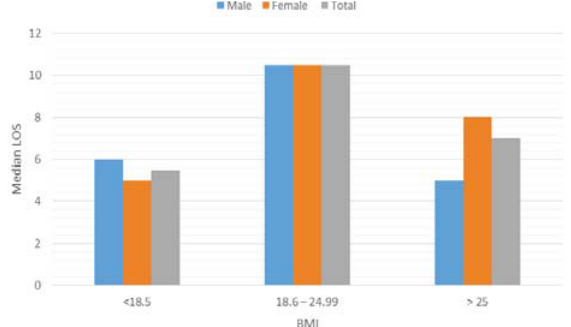
Figure 3. Median Length of Hospital Stay (LOS) in (cid:71)(cid:76)(cid:3445)(cid:72)(cid:85)(cid:72)(cid:81)(cid:87)(cid:3)(cid:37)(cid:48)(cid:44)(cid:3)(cid:74)(cid:85)(cid:82)(cid:88)(cid:83)(cid:86)